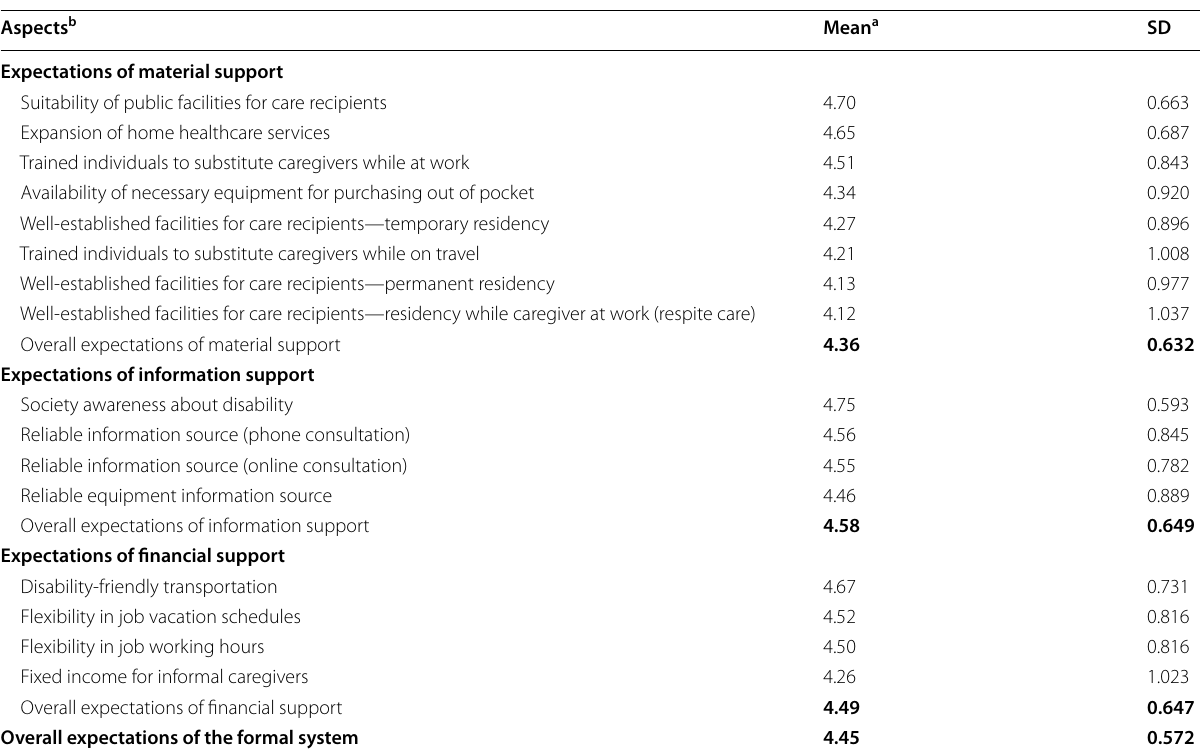
Table 4 Informal caregivers’ expectations of the formal system in Saudi Arabia, 2015 ( n